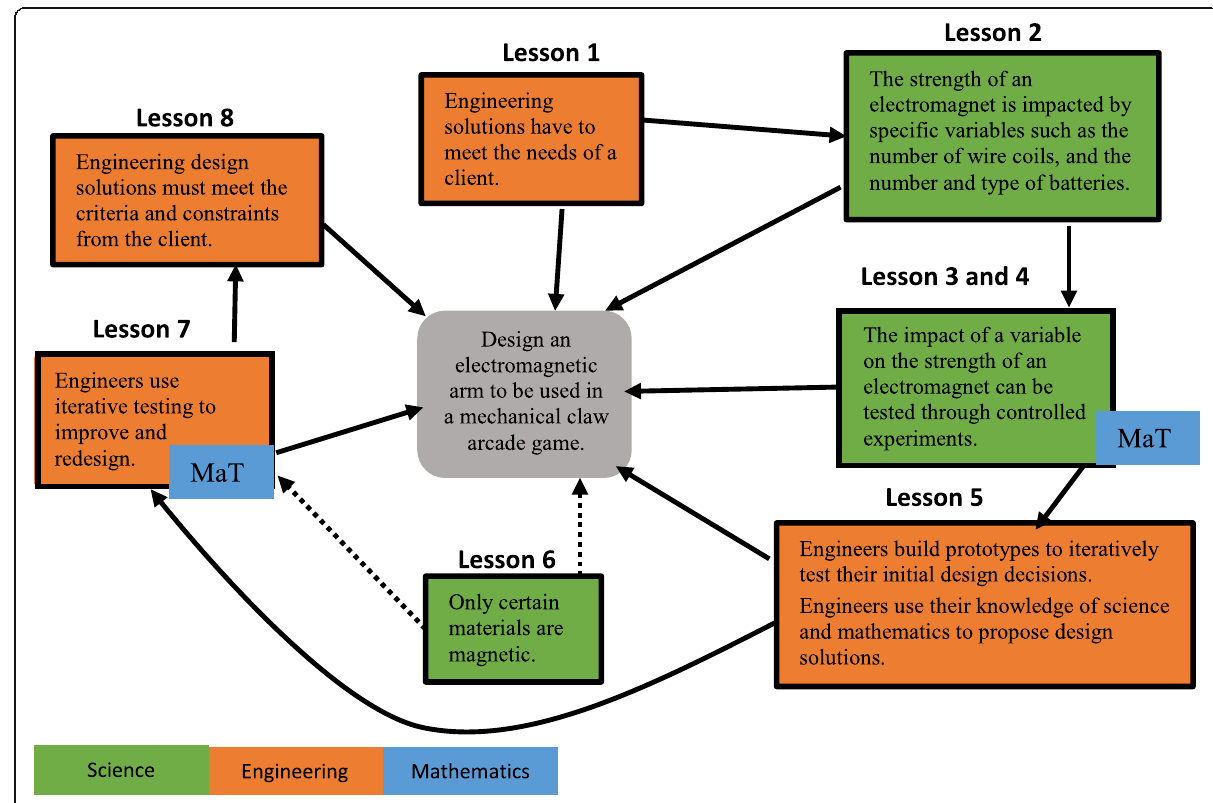
Fig. 5 Conceptual flow graphic for the Improving the Mechanical Claw